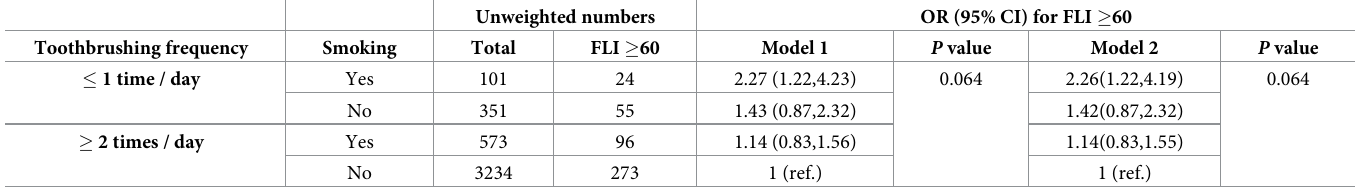
Table 3. Non-alcoholic fatty liver disease prevalence in multiple logistic regression models for toothbrushing frequency and smoking. Toothbrushing frequency